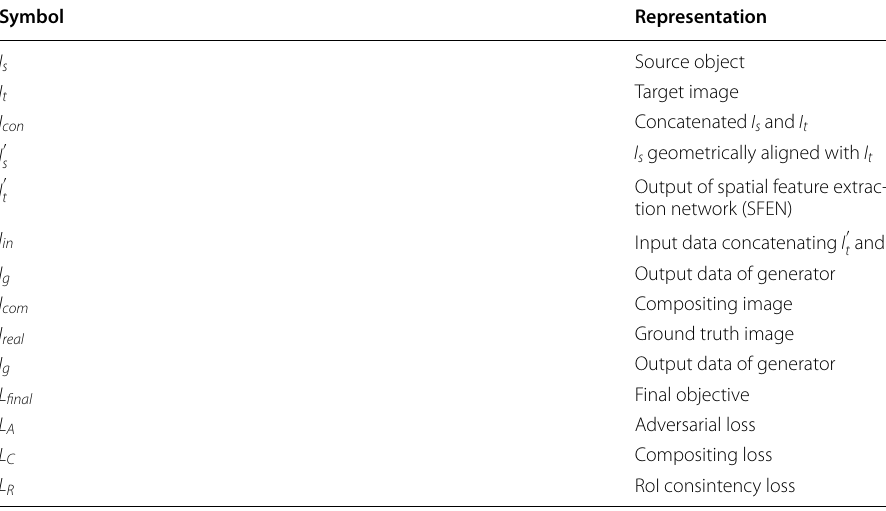
Table 1 Related mathematical symbols and their representation